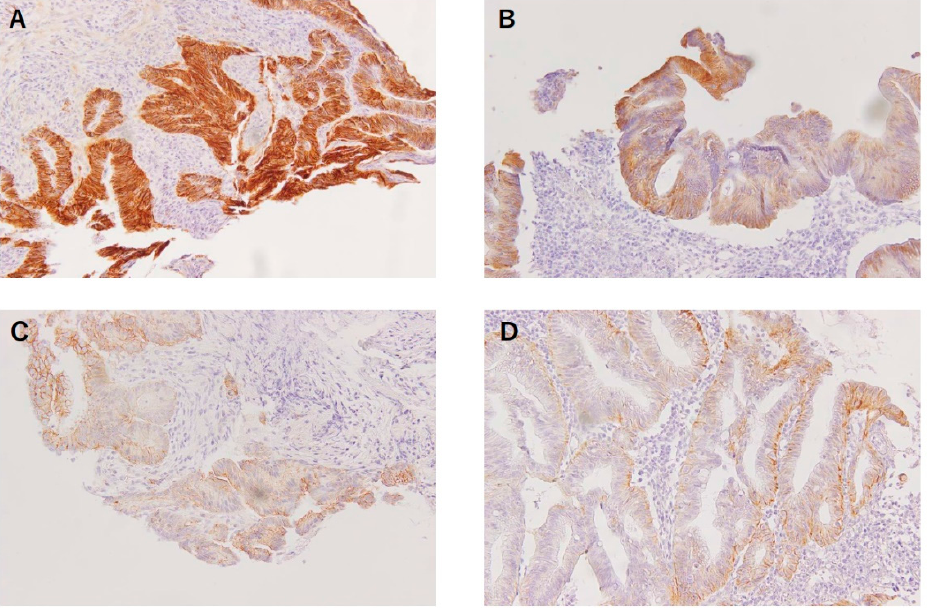
Figure 1. Nuclear β -catenin expression in biopsied rectal cancer samples before NACRT. Tumor cells corresponding to score 0 (<1% of positive cells) ( A ), score 1+ (1–5% of positive cells) ( B ), score 2+ (5–30% of positive cells) ( C ) and score 3+ (>30% of positive cells) ( D ).